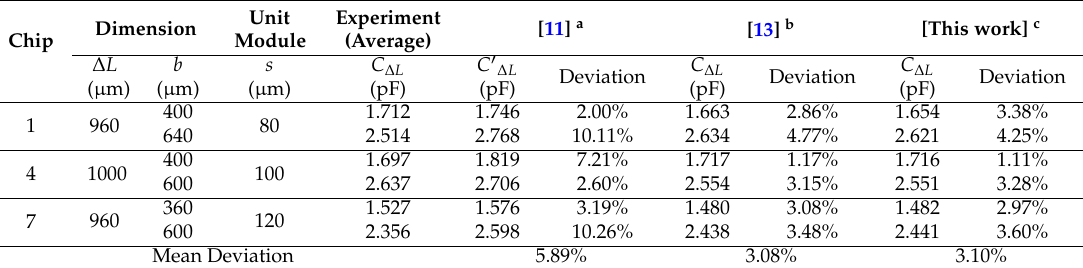
Table 7. Comparisons of capacitance between experiment and formulae ( µ = 0.7).